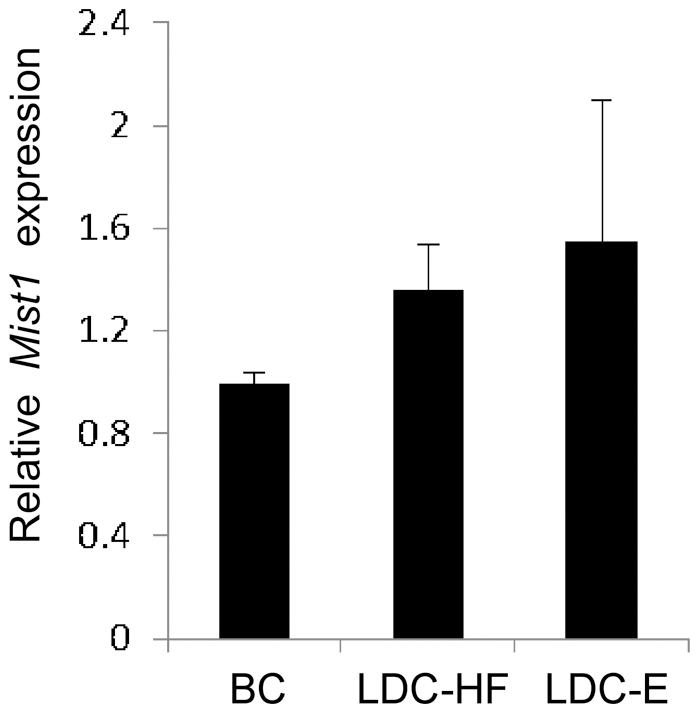
Mist1 expression is not altered in response to ethanol feeding.Quantitative RT-PCR shows no difference in Mist1 levels in response to either LDC-E or LDC-HF diets. Error bars = mean ± SE (n = 3).